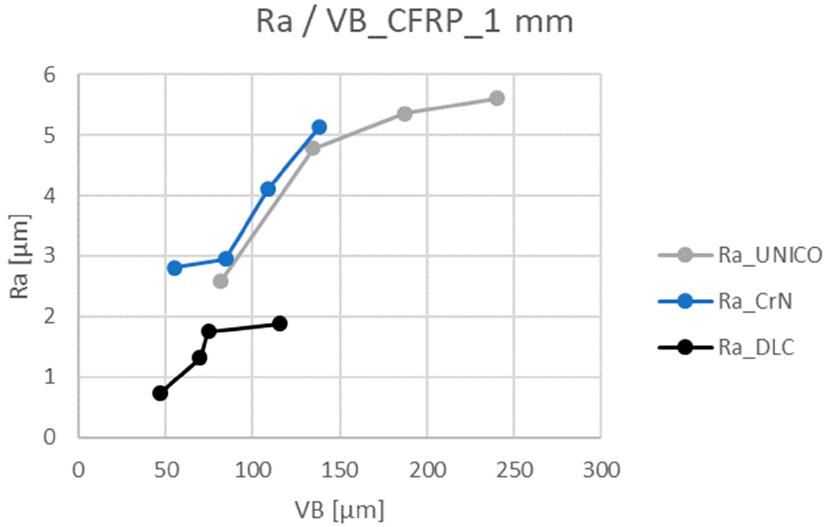
Figure 17. Dependence of the surface roughness parameter R a on wear, laminate thickness 1 mm. R a —arithmetical mean high. VB—flank wear.